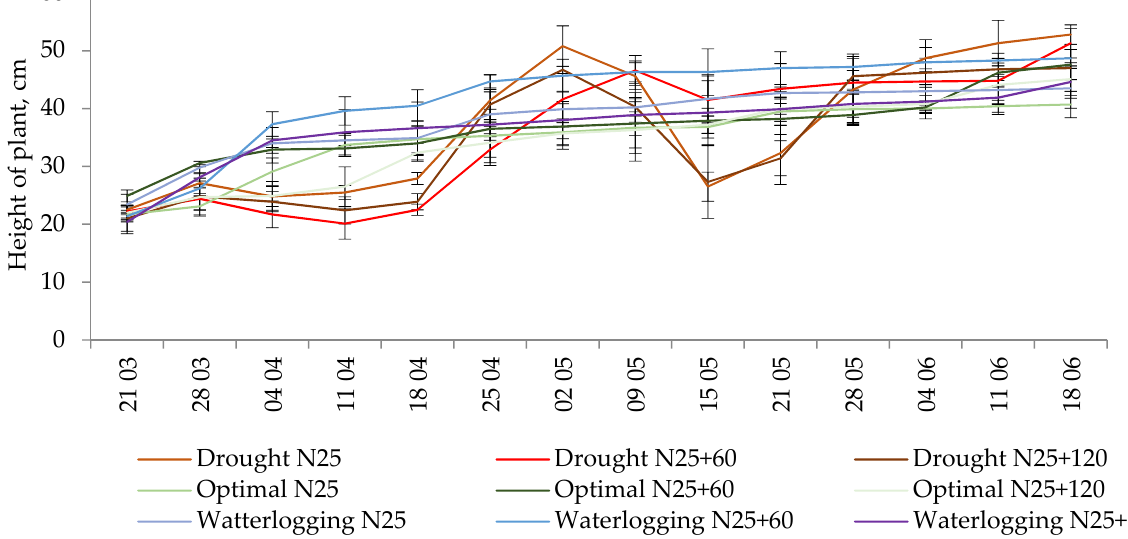
Figure 5. Growing dynamics of forage timothy. Note, whiskers indicate standard errors of the means.